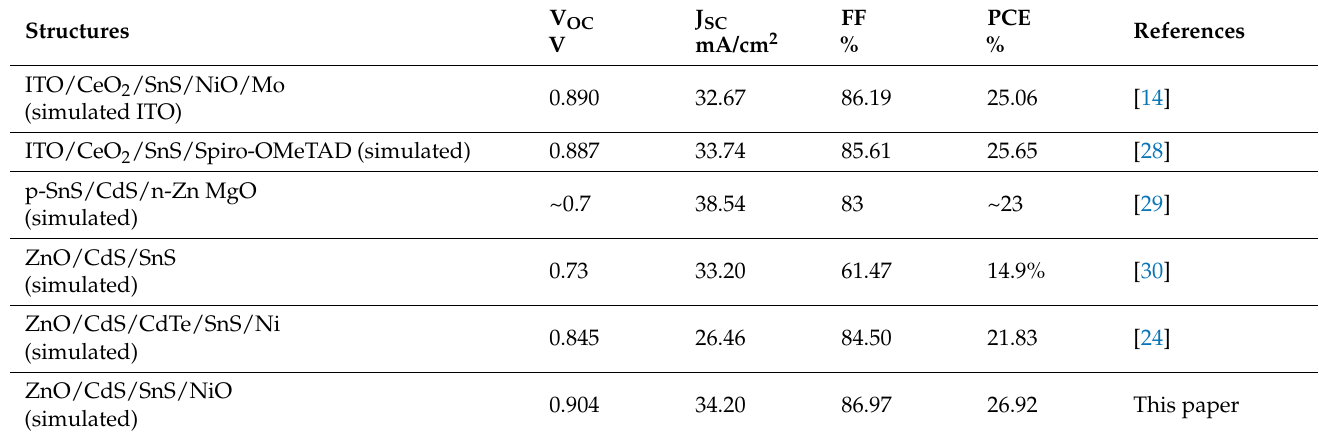
Table 3. Comparison of previously reported results to proposed